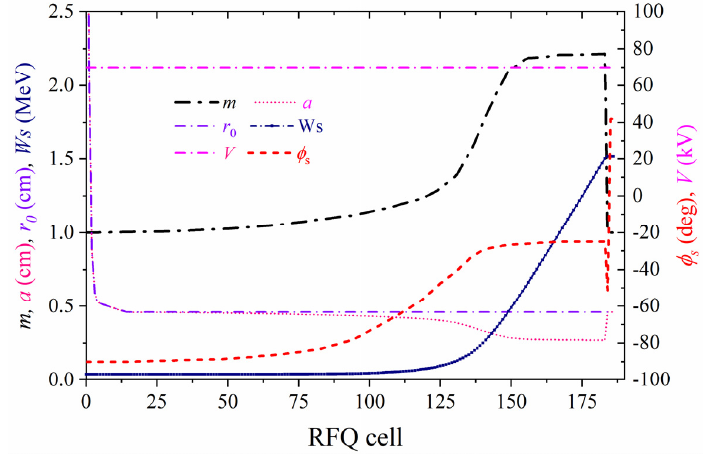
Figure 3. Evolution of the RFQ design parameters along the RFQ cell after optimization.